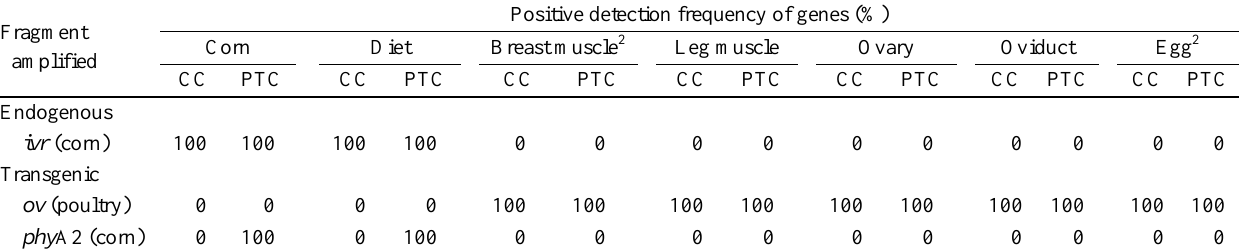
Table 4. Detection of corn-specific invertase gene ( ivr ), poultry-specific genes ( ov ) and transgenic gene ( phy A2) in corn, diet, tissues